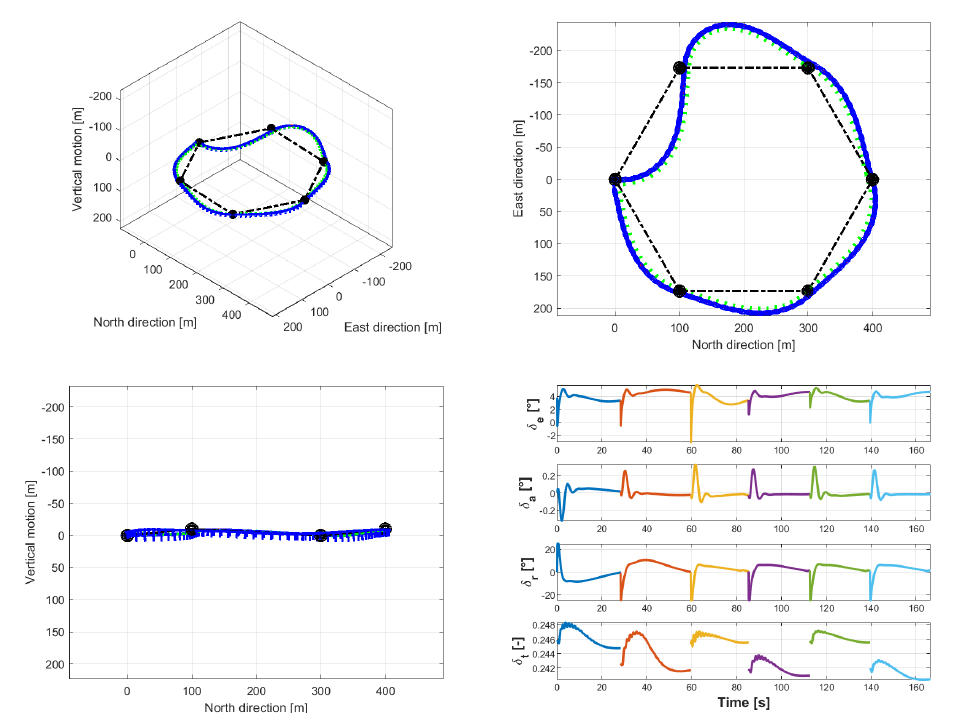
Figure 15. Trajectory and control behavior for a six-checkpoints circuit, flown by the stabilized baseline airship, at 8 m/s of ground speed. ( Top-left ) three-quarter view of the 3D trajectory from the northeast. ( Bottom-left ) view of the trajectory from the east. ( Top-right ) view of the trajectory from the top. Black dash-dotted lines: target track. Black spheres: target checkpoint capture volume. ( Bottom-right ) time histories of controls (a different color for each